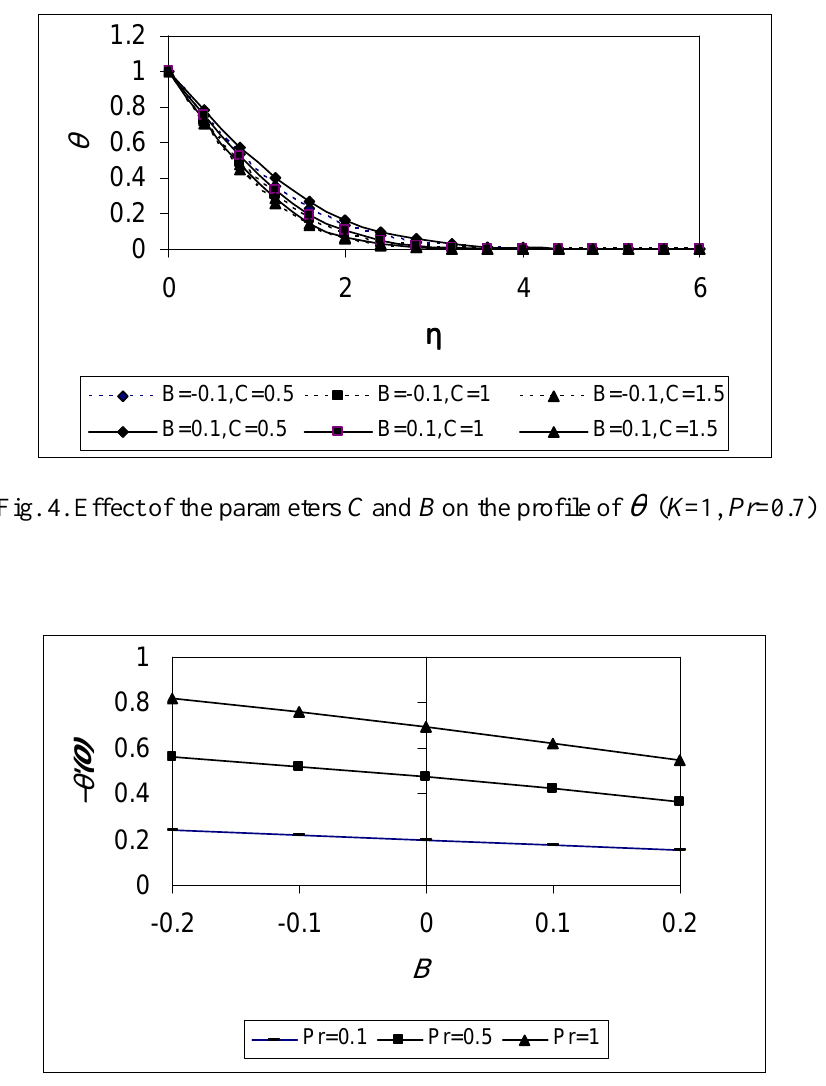
¢- with B various values of Pr ( C =0.5,